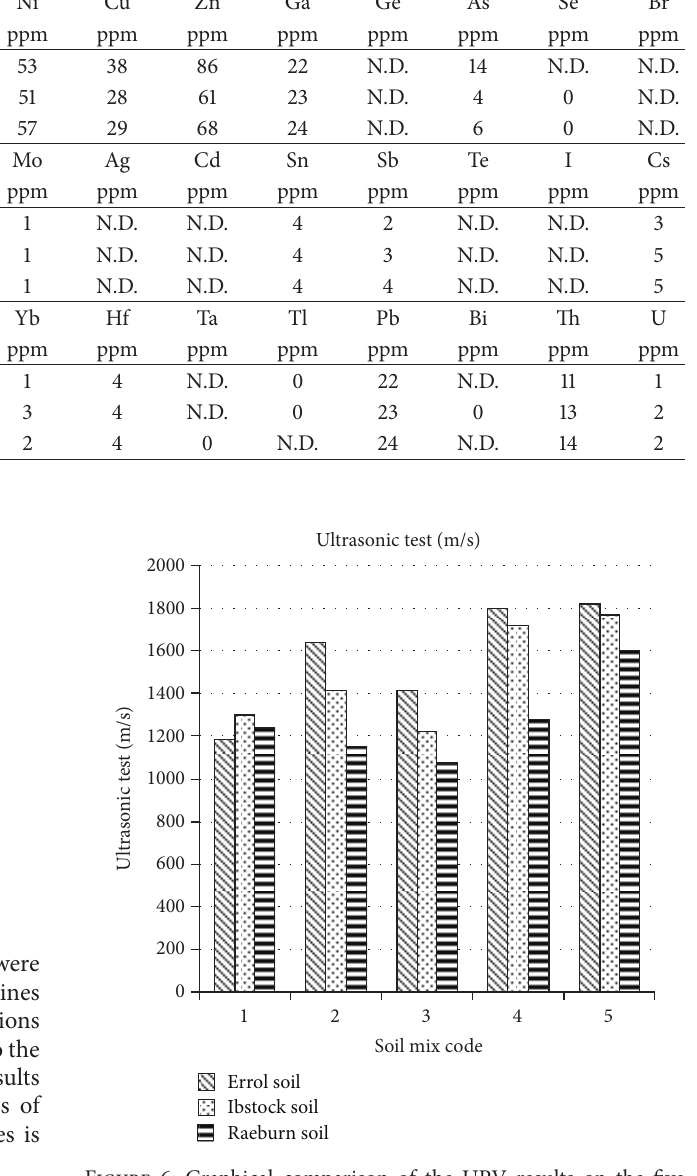
Figure 6: Graphical comparison of the UPV results on the five different mixes of the three types of